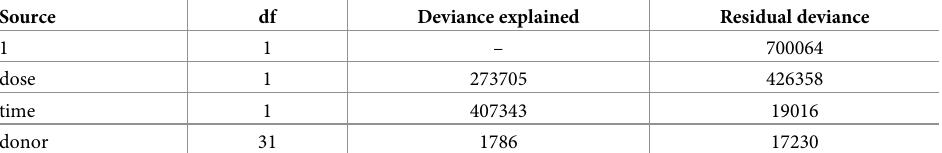
Table 3. Analysis of deviance for Poisson linear model involving factors for time (1h/24h) and donor ID (1, ... ,